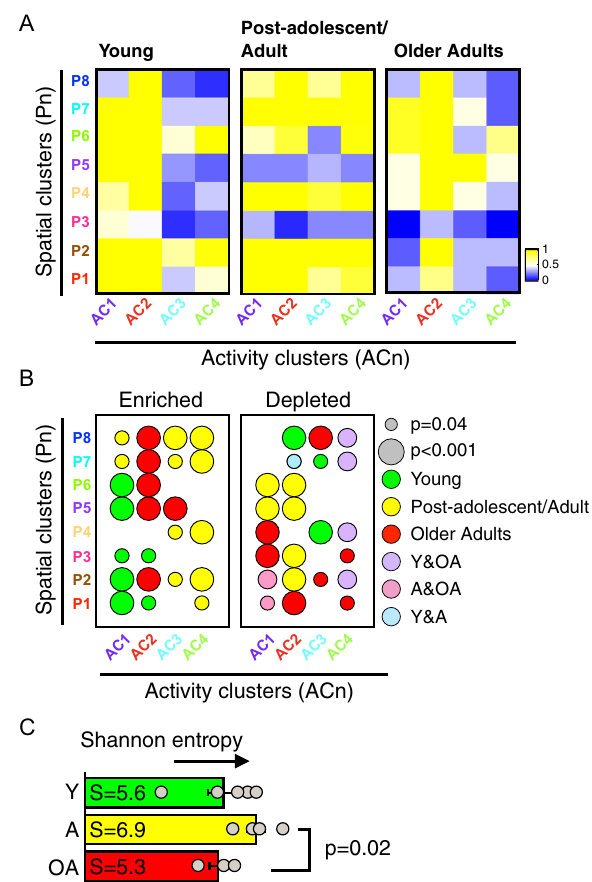
Fig. 4 Spatial and activity clusters de fi ne age-dependent cell motility states. A Heatmaps showing the frequency per motility state de fi ned by the eight spatial and four activity clusters: young (A02, A03, A09, A11, and A16), post-adolescent/adult (A29, A35, A45, and A55), and older adults (A65, A85, and A92). Color scales indicate the frequencies of cells within each motility state, yellow denotes high frequencies and blue denotes low frequencies. B Enrichment and depletion maps corresponding to motility states as a function of age-group. Size of the node denotes the magnitude of the p -value, and colors denote young (green), post-adolescent/adults (yellow), older adults (red). C Quanti fi cation of the Shannon entropy based on age-group de fi ned motility